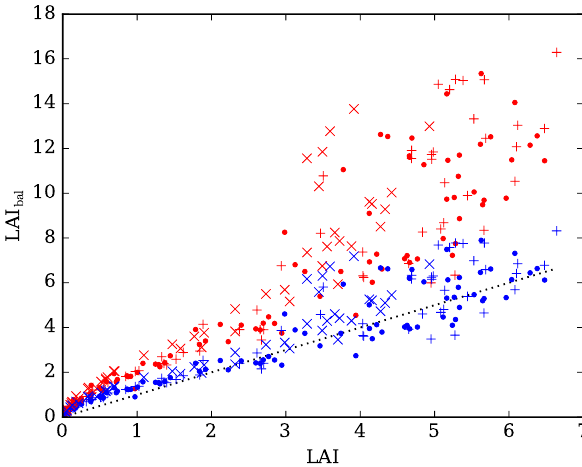
Figure 11. Height against stem biomass. Dots, vertical crosses (+) and diagonal crosses (x) are US-Ne1, US-Ne2 and US-Ne3 obser- vations respectively. Solid line shows the fit using natural PFT pa- rameters from Osborne et al. (2015) and dashed line shows a tuned fit using the relations for natural vegetation described in Sect. A2. Only points up until the maximum stem biomass for that site in that year are plotted.